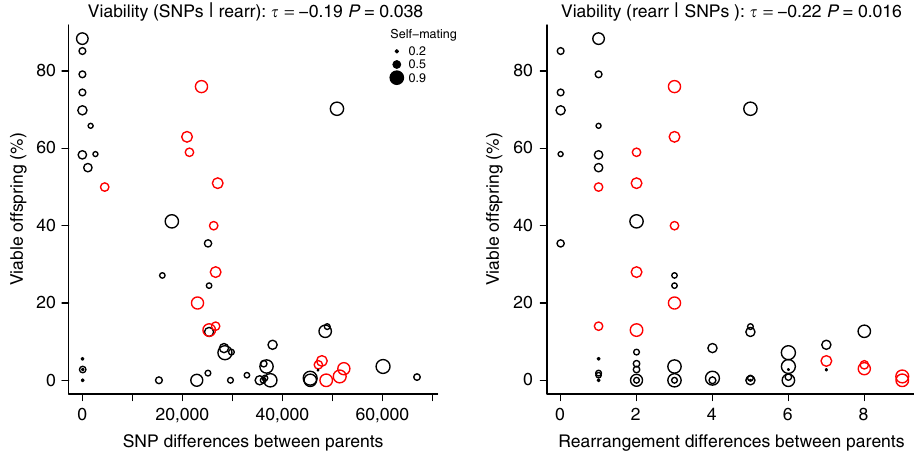
Jeffares et al. 17 (black) or Avelar et al. 6 (red), with each circle in the plots representing one cross. An additive linear model incorporating both SNP and rearrangement differences showed highly significant correlations with viability ( P ¼ 1.2 (cid:2) 10 (cid:3) 6 , r 2 ¼ 0.39). Both genetic distances measured using SNPs correlations with viability SNPs|rearrangements t ¼ (cid:3) 0.19, P ¼ 0.038; rearrangements|SNPs t ¼ (cid:3) 0.22, P ¼ 0.016). Some strains produce